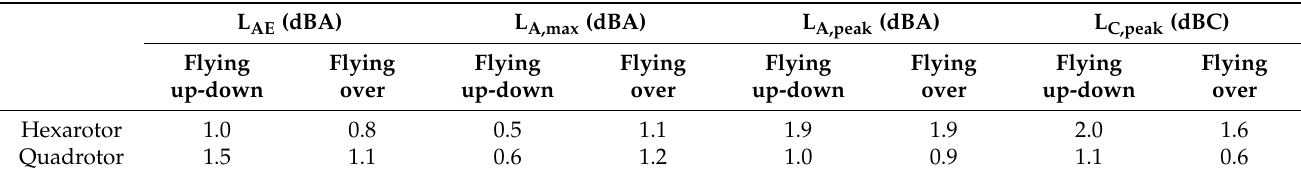
Table 4. Experimental measurement uncertainty (u sou